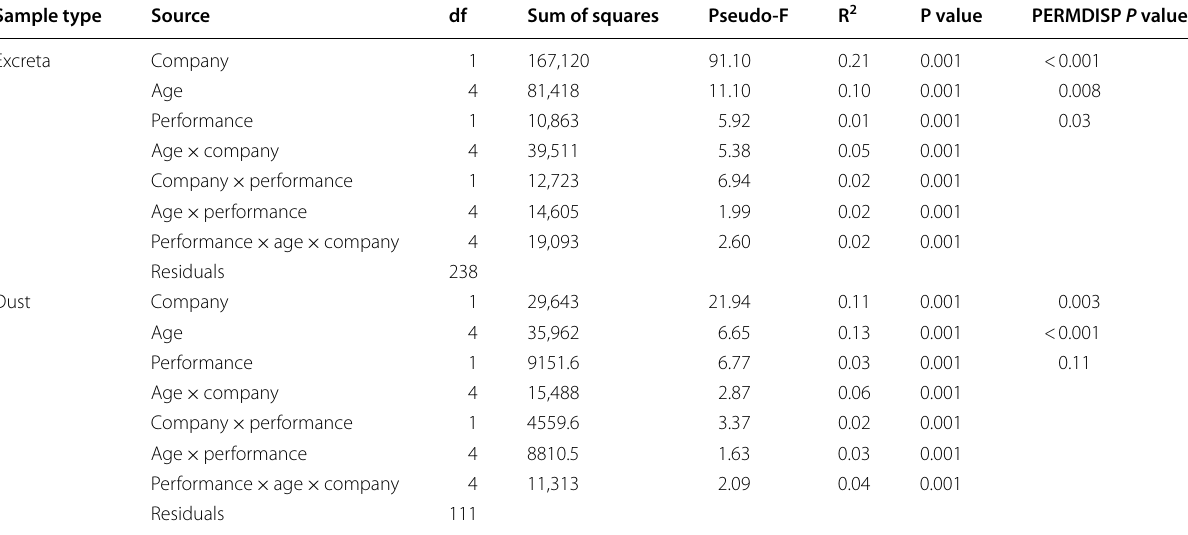
Df, degrees of freedom; R 2 , proportion of the variance explained by each model; PERMDISP, permutational analyses of multivariate dispersion